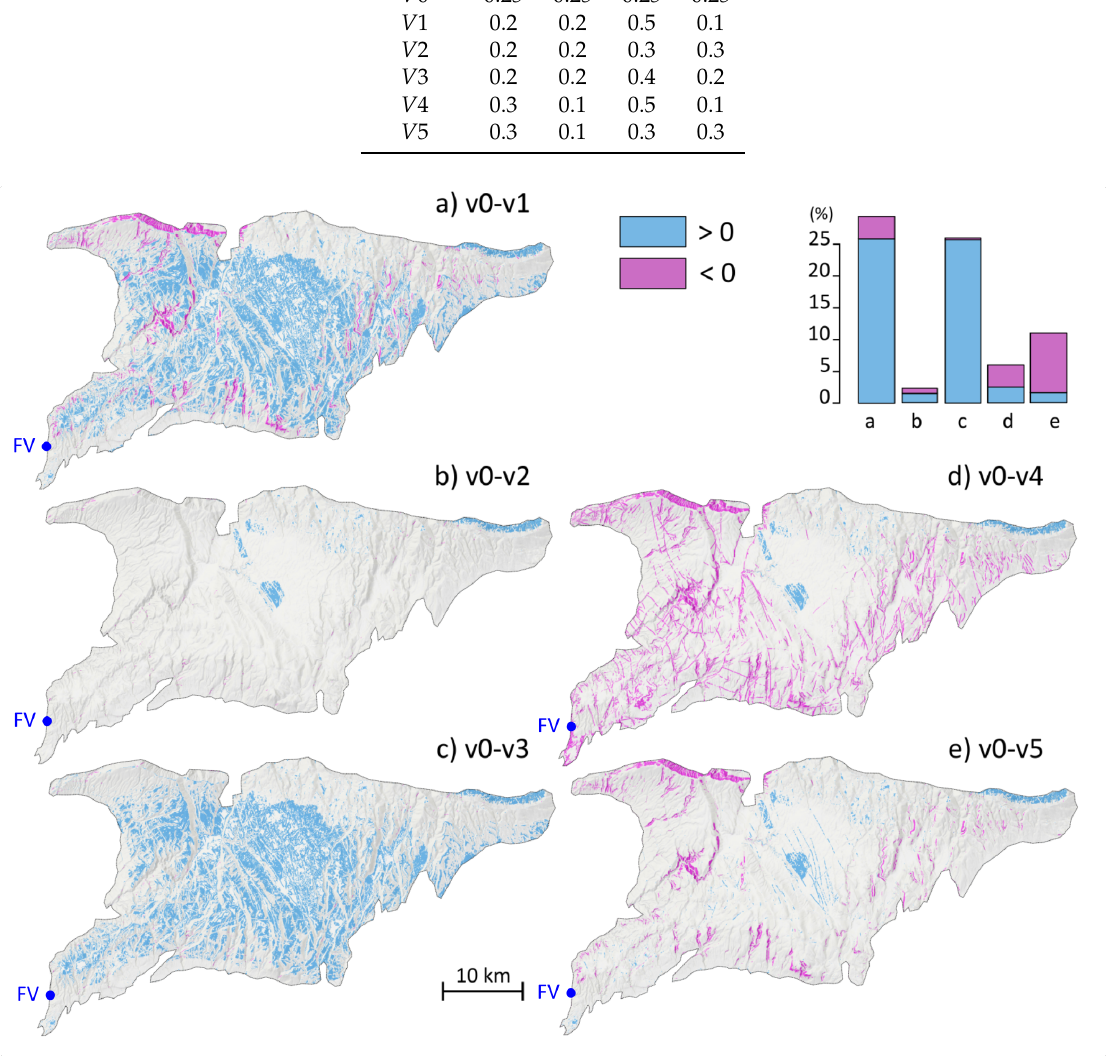
Figure 8. The vulnerability index is computed according to the weighting system shown in Table 3 and compared with V 0. The pink color indicates that the tested system provides indices lower than V 0 and the blue color shows indices above V 0. Compared to the vulnerability index obtained with the weighting system V 0: ( a ) most of the system has a higher index with the system V 1, ( b ) the indices obtained with V 2 are close to those of V 0, ( c ) most of the system has a higher index with V 3, d ) most dry valleys have a lower index with V 4, ( e ) very flat or very steep areas have a higher and lower index respectively. The diagram shows that it is the weighting systems V 1 and V 3 that involve the most difference with V